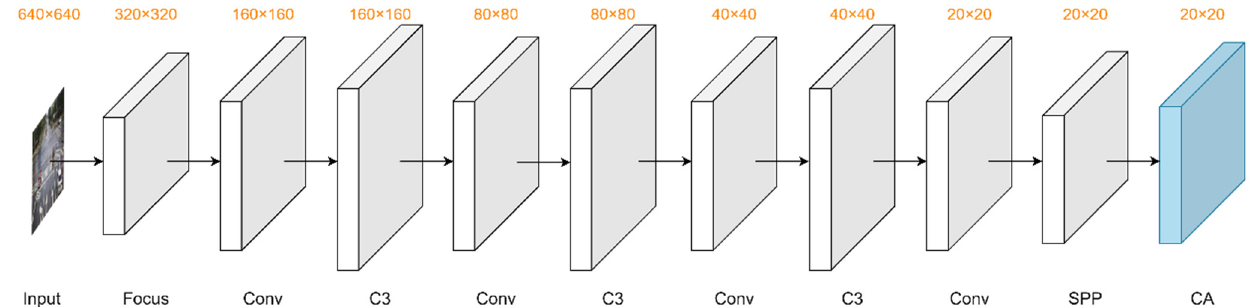
Figure 8. The Backbone structure with the CA module. We integrate the CA to enhance the correlation between feature channels. Then, the network can focus on important features in the roadside images.